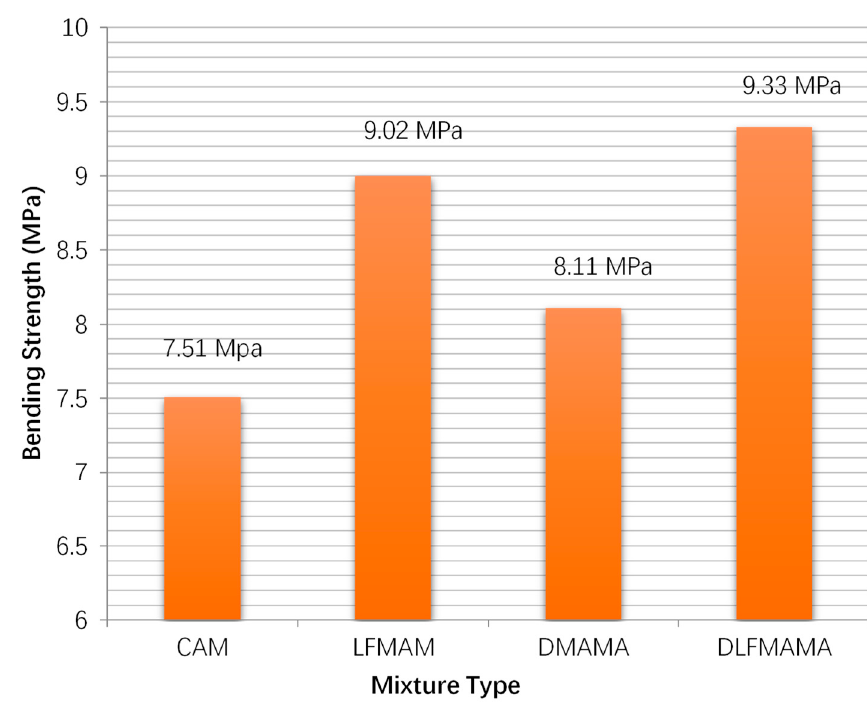
Figure 5. Bending strength of asphalt mixes.